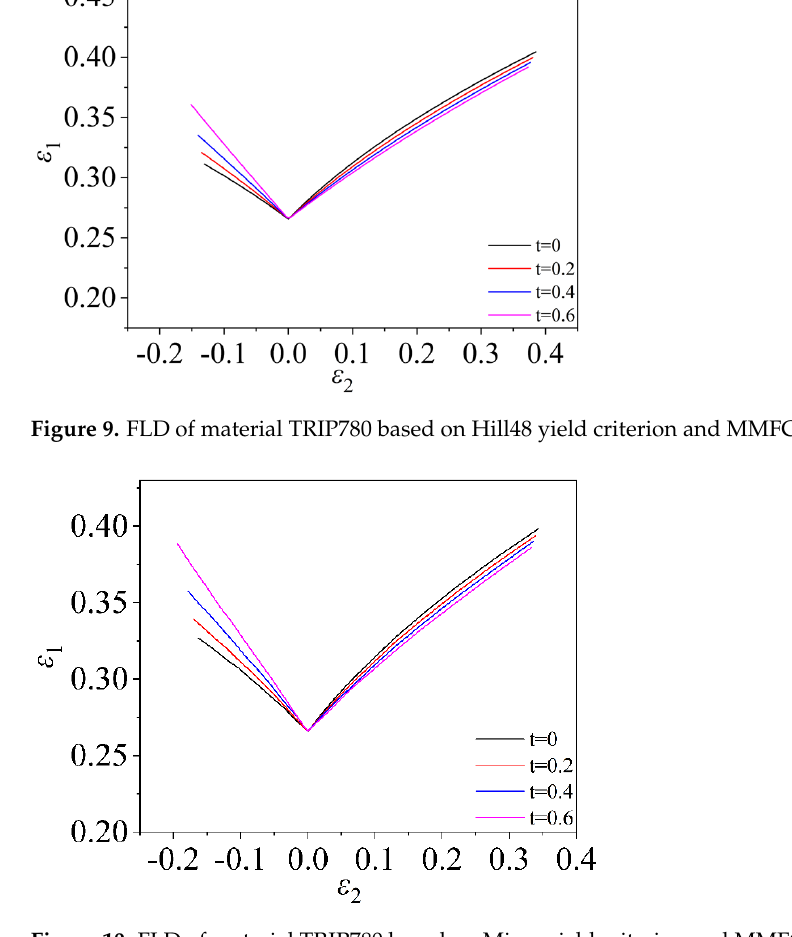
Figure 10. FLD of material TRIP780 based on Mises yield criterion and MMFC instability criterion. Compared with applying the stress in the thickness direction all the time in the deformation process, the FLC which considers the induced stress in the thickness direction has changed significantly. As can be seen from the figure, the plane strain point of the FLC does not change. In the tension and compression zone, when the given multiple t increases (the same loading time, larger stress in the thickness direction is induced inside the sheet), the FLC is significantly increased, and the range of forming limits is increased; the curve gradually becomes longer as t increases. The curve is the longest when t = 0.6, indicating that the ultimate strain of the corresponding strain state